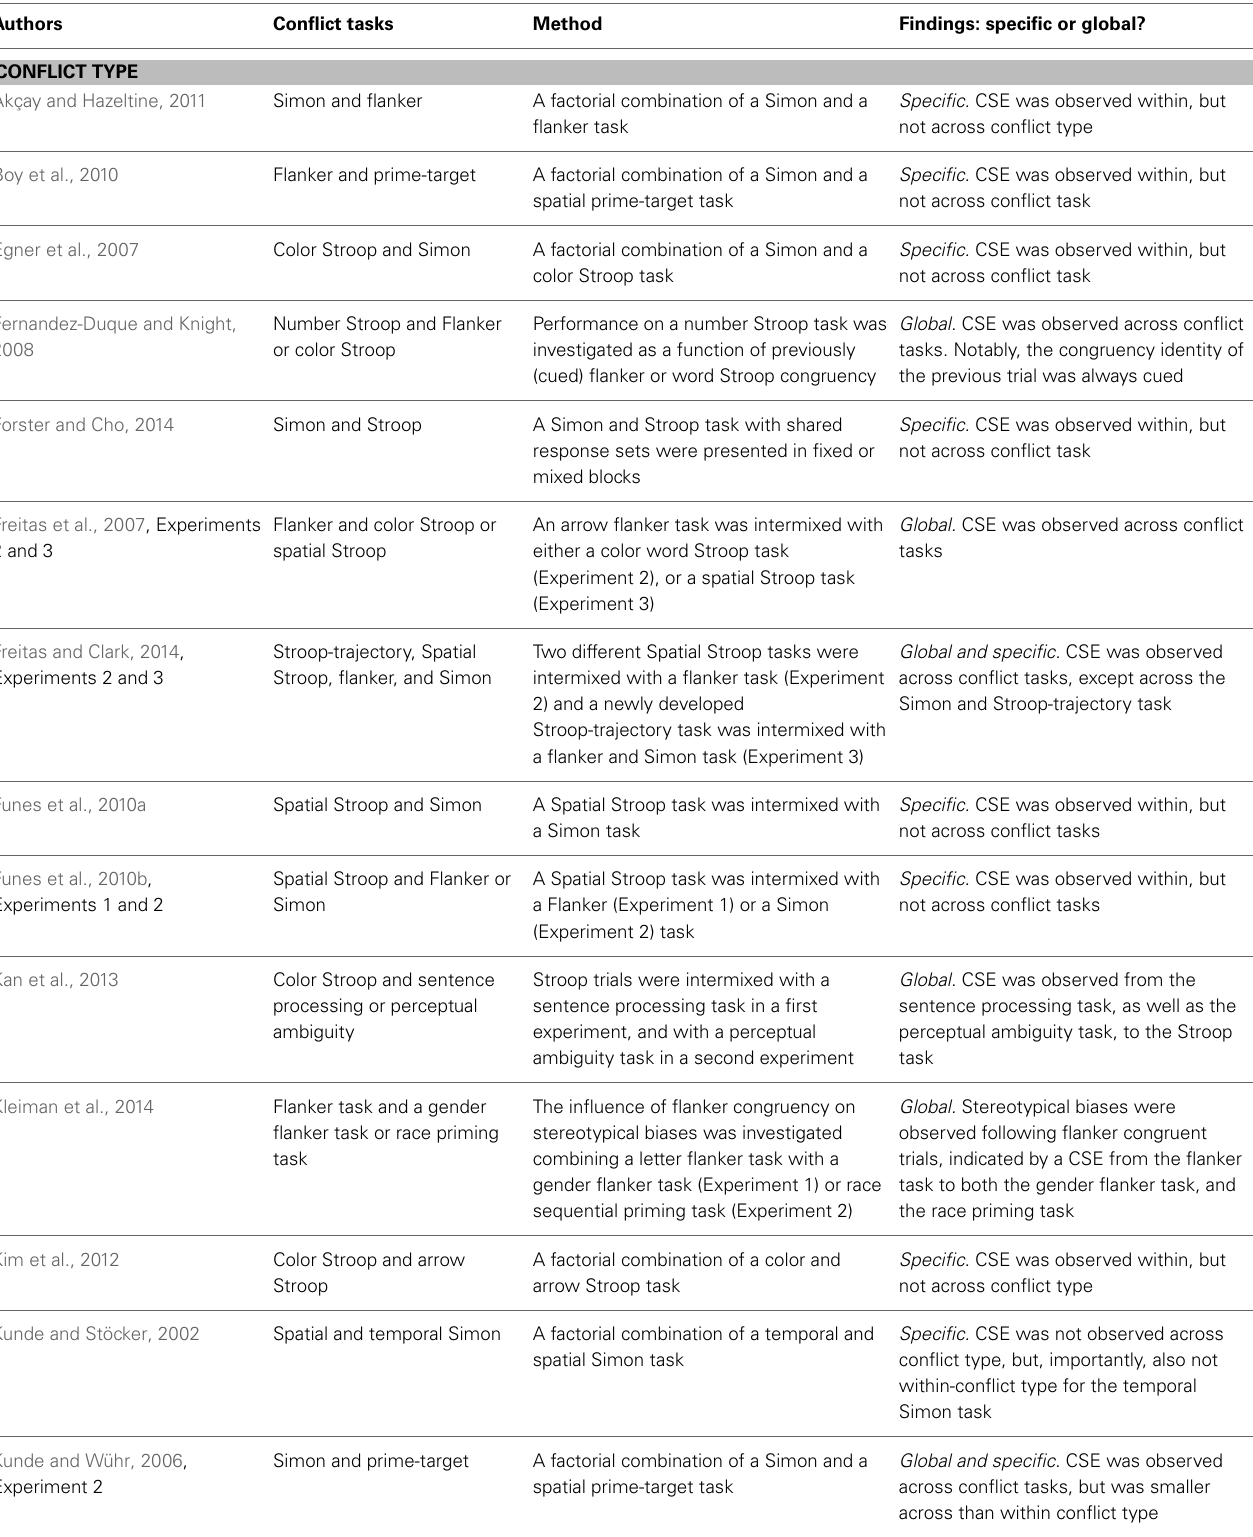
Table 2 | Studies investigating the scope of cognitive control, using the congruency sequence effect